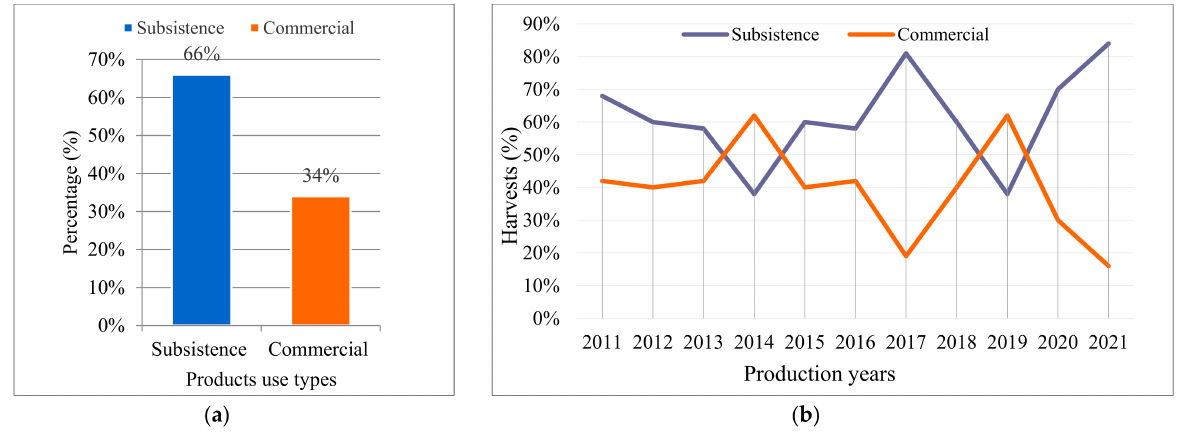
Figure 3. Product use types for C. mopane from 2011 to 2021; ( a ) percentage of two main types of use, and ( b ): trends in the harvests of products by use type from 2011–2021.